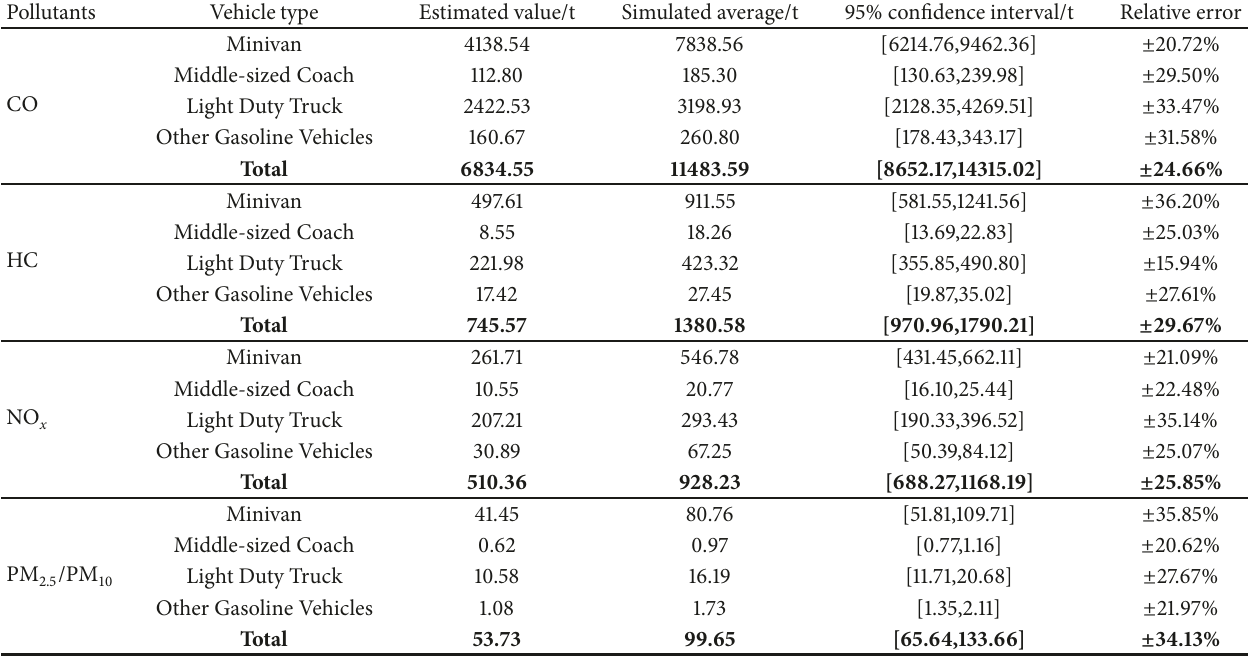
Table 14: Uncertainly analysis of the emission inventory of gasoline vehicles.